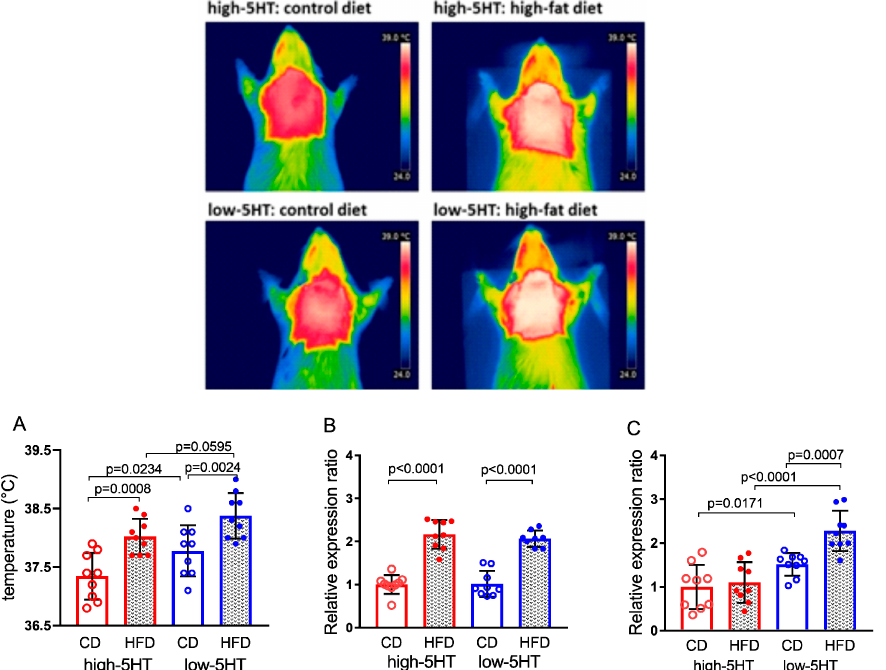
Figure 7. Top: Representative thermographic images of the interscapular region of animals from the 5HT sublines obtained after 8.5 weeks of control diet (CD) or high-fat diet (HFD), taken with a digital infrared camera. Bottom: ( A ) Temperature of skin over interscapular brown adipose tissue (BAT) obtained by analysis of thermographic images. ( B , C ) mRNA expression levels of ( B ) uncoupled protein 1 ( Ucp1 ) and ( C ) fibroblast growth factor 21 ( Fgf 21 ) in BAT of animals from the high-5HT and low-5HT sublines after 11 weeks of CD or HFD. Expression levels were normalized to the mean of two reference genes ( Gapdh and RpS29 ) and are shown as relative expression ratios between groups, with high-5HT animals receiving control diet set at 1.0. Data presented as individual values and means ± SD; N = 9 rats per group; p -values obtained by LSD post-hoc test after one-way ANOVA. In both 5HT sublines, increased BAT thermogenesis was accompanied by upregulation of thermogenic uncoupling protein 1 ( Ucp1 ) mRNA levels in BAT (L-HFD/L-CD = 2.03, H-HFD/H-CD = 2.16) (Figure 7B). On the other hand, mRNA levels of fibroblast growth factor 21 ( Fgf21 ) in BAT were upregulated by HFD feeding only in low-5HT animals (L-HFD/L-CD = 1.51, H-HFD/H-CD = 1.10) (Figure